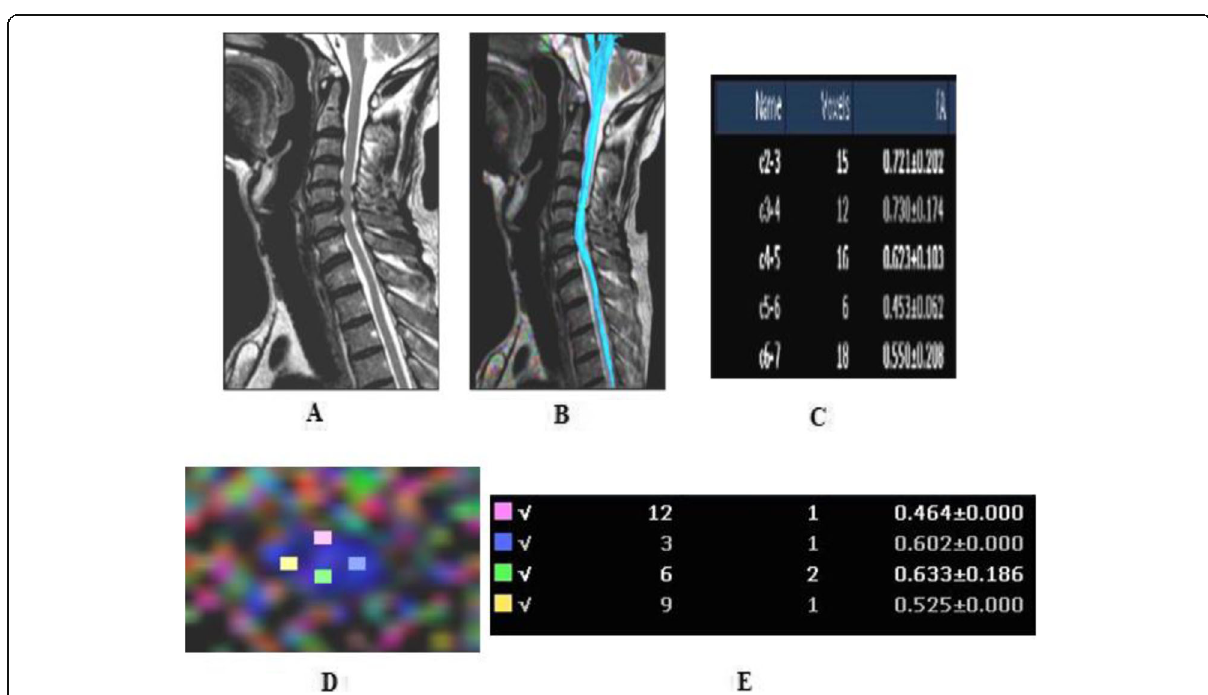
Fig. 5 Fifty-nine-year-old male patient, presented with neck pain and right brachialgia. a Sagittal T2 WI of the cervical spine showing C2-3 down to C6-7 posterior disc lesions with cord indentation at C5-6 level, with no signal intensity alteration of the cord. Ligamenta flava hypertrophy are seen at C4-5, C5-6, and C6-7 levels. b DTI fiber tractography of the cervical cord, showing grossly intact fiber tracts. c FA values opposite to all the examined cervical discs, showing moderate reduction of FA value of the whole cord circumference opposite to C5-6 level (the most affected disc level) denoting myelopathy and mild reduction opposite to C6-7 disc level (the level below the most affected disc). Mild reduction of FA value is seen opposite to C4-5 level as well. d , e FA values of the spinal cord at 3, 6, 9, and 12 o ’ clock positions opposite to C5-6 disc level, showing the reduction in FA value is more pronounced opposite to 12 o ’